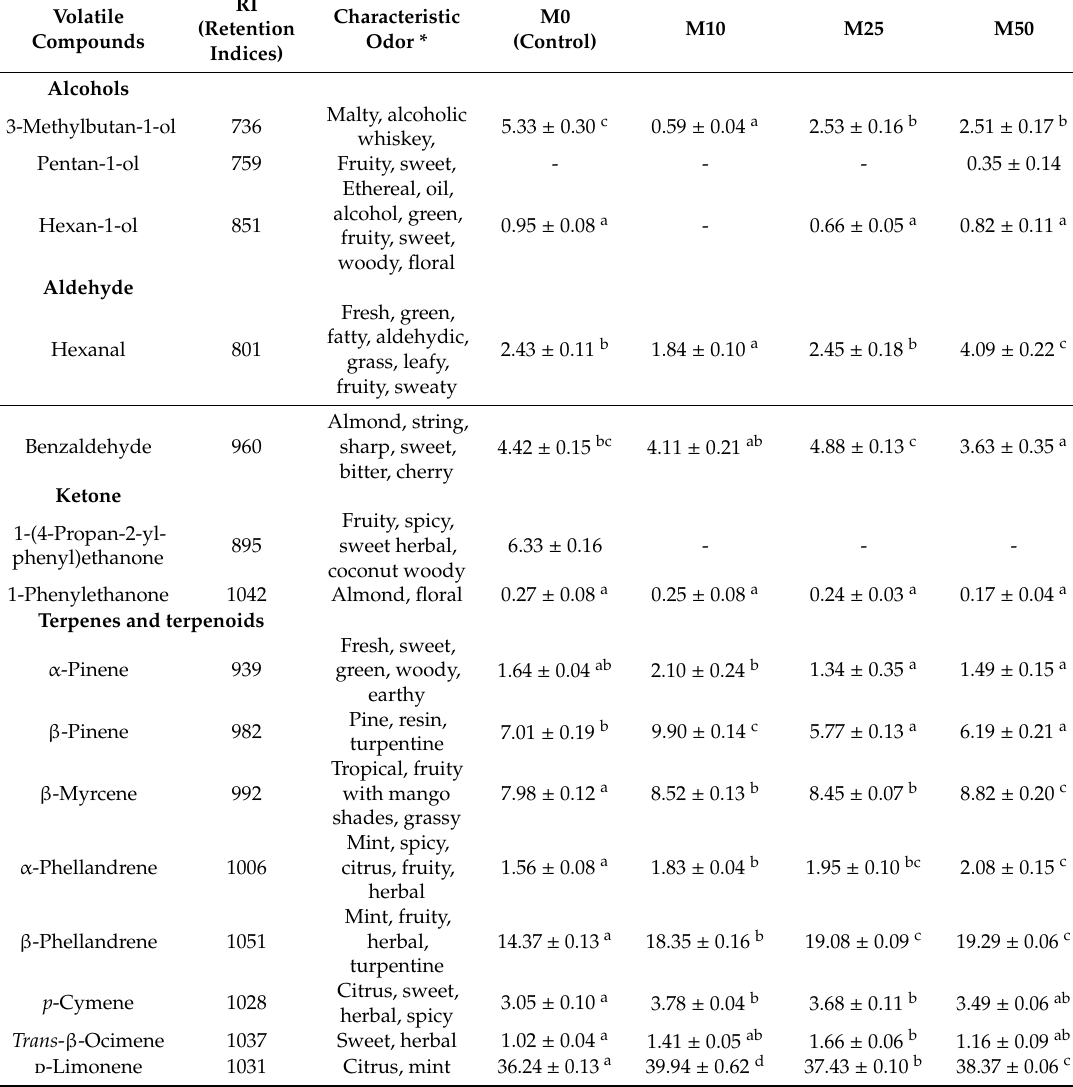
Table 6. Volatile compounds content of the modified macarons with walnut